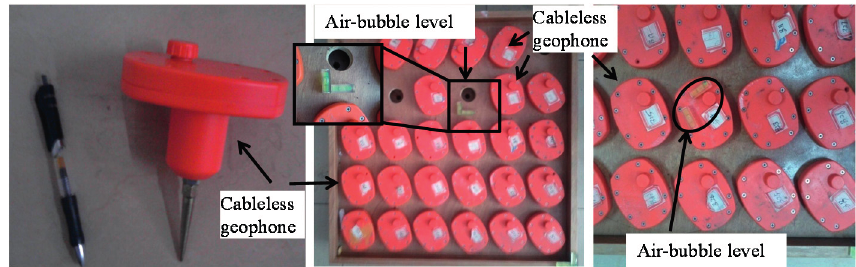
Figure 5. Cableless geophone correlation test